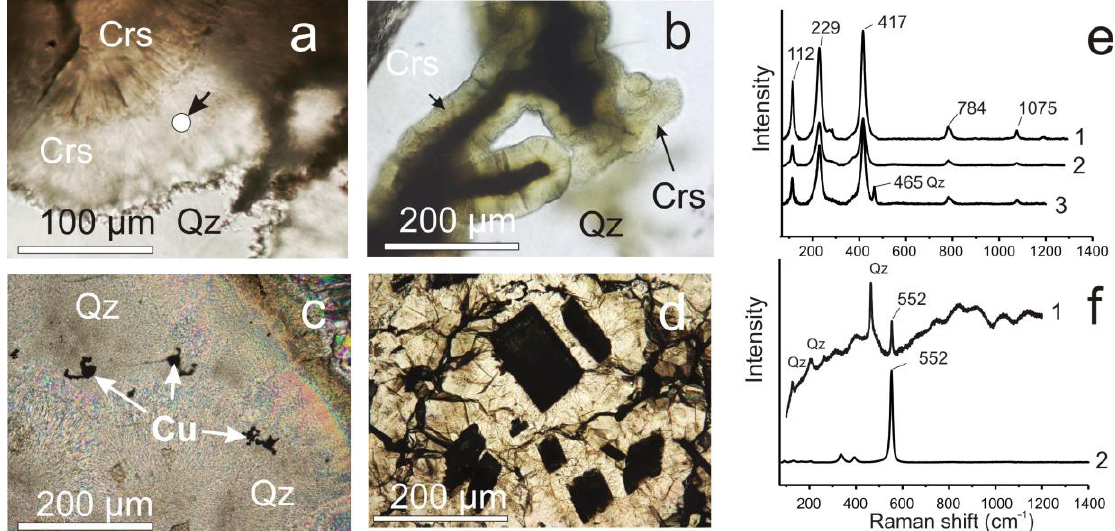
Figure 9. Photographs in the transmitted light of agate No. 8 with native copper: ( a ) cristobalite, the arrow indicates one of the points of exposure of its Raman spectrum (Figure 9e, spectrum 3); ( b ) cristobalite among a fine-grained aggregate of spherulite quartz; ( c ) grains of native copper in quartz at the contacts of intergrown quartz spherulites (crossed polars); ( d ) voids of leaching among quartz. The voids are partially filled with quartz aggregate. Raman spectra of the agate: ( e ) spectra of cristobalite (1 and 2) from the RRUFF database [39], respectively, cristobalite spectra X050046 and X050047; the colloform SiO 2 structures spectrum (3) in the point of exposure Figure 9a; ( f ) spectrum of SiO 2 and cryolite on the surface of the void (1) among quartz and the spectrum of cryolite (2) from the RRUFF database, Cryolite R050287 [39].